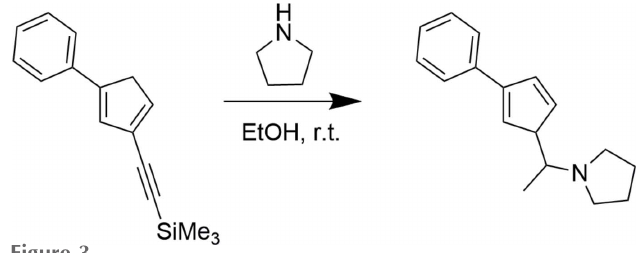
Figure 3 Reaction